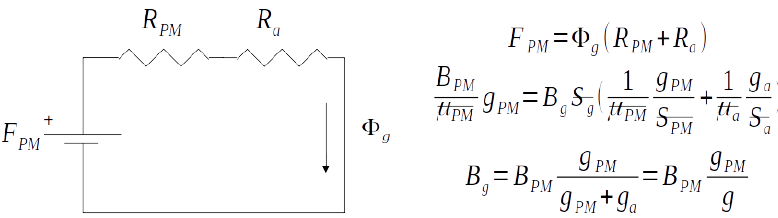
Figure 5. Equivalent circuit for the analysis of the effective air